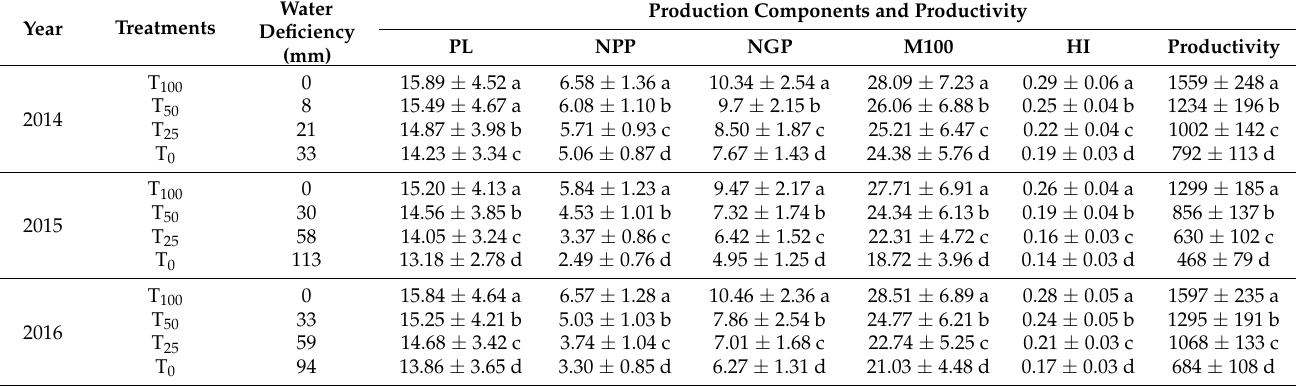
Table 3. Total accumulated deficiency in the reproductive phase and average of the components of production: pod length (PL), number of pods per plant (NPP), number of grains per pod (NGP), mass of 100 grains (M100), harvest index (HI), and cowpea productivity, under different irrigation depths in